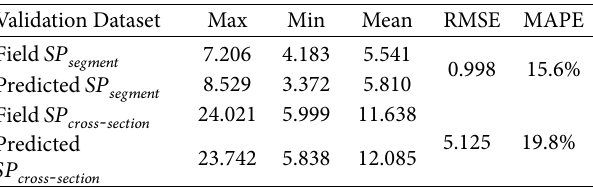
Table 5: Model validation